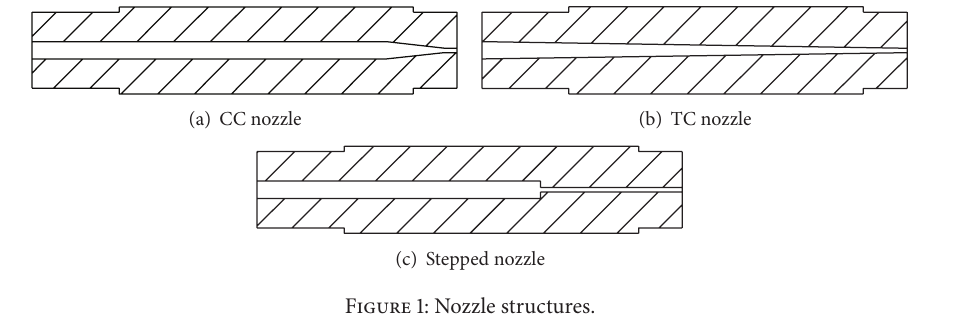
Figure 1: Nozzle structures.